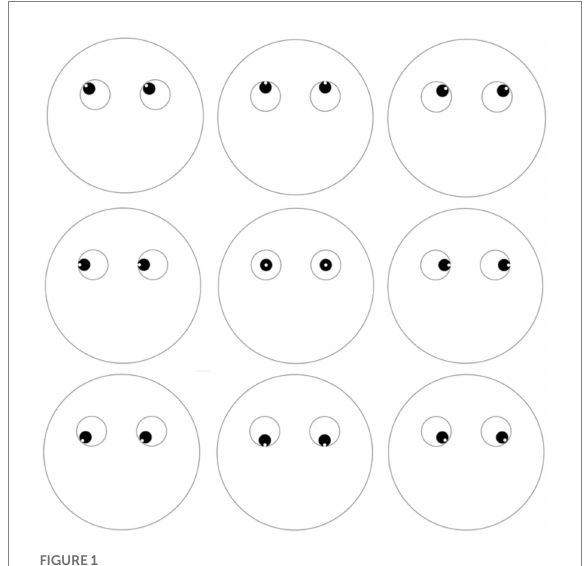
FIGURE 1 Stimuli presented in Experiments 1a and